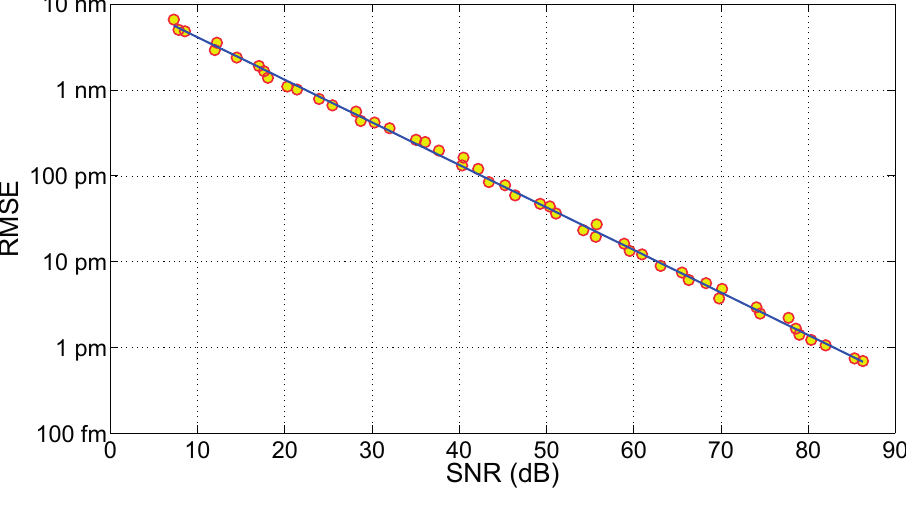
Figure 9. RMSE on FPI cavity length detection, as a function of SNR, using KLT-based algorithm for short- Δ L; the chart shows the estimation (dots) and linear fit